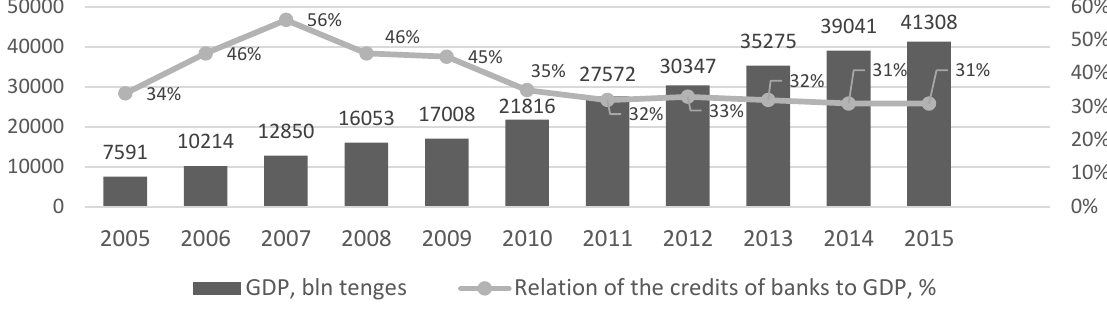
Figure 1. Analysis of changes in GDP in bln KZT, the ratio of loans to GDP and loans in the real sector, % in 10-year period in the Republic of